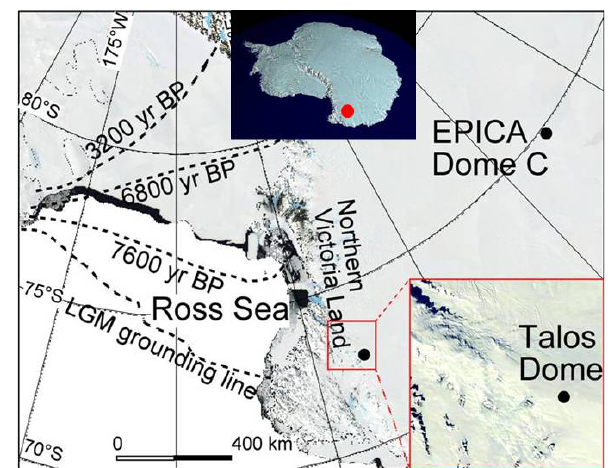
Fig. 1. Satellite image (Landsat Image Mosaic of Antarctica Project) of the Ross Sea and Dome C area. The top insert shows the approximate location of Talos Dome (red dot) in Antarctica (A RADARSAT Map of Antarctica. Credit: AMM, SVS, NASA, CSA. Source: http://apod.nasa.gov/apod/ap991116.html). The insert on the bottom-right side shows the Talos Dome area. Dashed lines with accompanying time indication show the timing of the Ross Ice Shelf grounding line retreat (Conway et al., 1999; Hall,